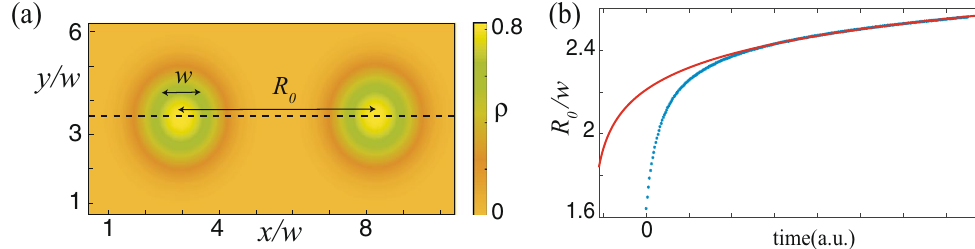
Figure 3. Interaction of two localised patches, top panels interaction-redistribution model Eq. (3). ( a ) Two localised patches separates by R 0 ( t ) distance. ( b ) Temporal evolution of the distance between the localised patches R 0 ( t ) with periodic boundary conditions. The dotted line corresponds to numerical data, while the solid line to the curve fitting by equation γ = R t w ln At ( )/ (1/ ) ( ) , with γ and A as fitting parameters. Simulation 0 parameters used are η = 0.12, κ = 0.6, Δ = 0.02, Γ = 0.5, and α =